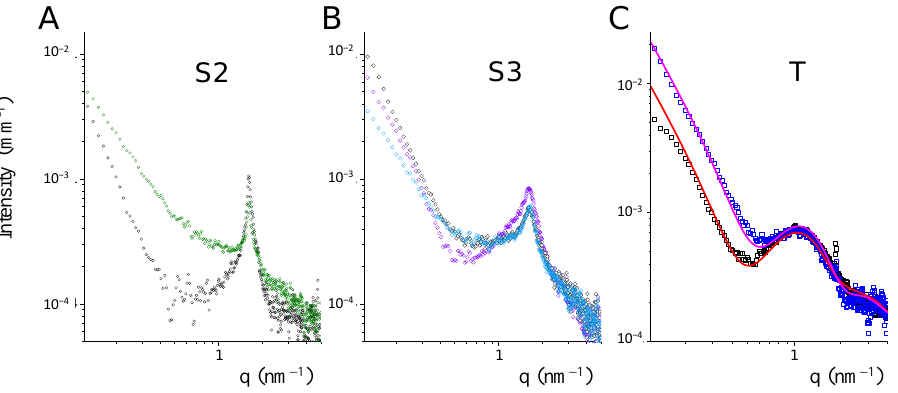
Figure 4. SAXS intensity spectra of Span-based and Tween-based niosomes. Panel ( A ) S2 sample without (black dots) and in presence of HA-Chol (1:1) molar ratio (green dots). Panel ( B ) S3 sample without (black diamonds) and in presence of HA-Chol (1:0.5) molar ratio (light blue diamonds) and (1:1) molar ratio (violet diamonds). Panel ( C ) T sample without (black squares) and in presence of HA-Chol (1:1) molar ratio (blue squares). Lines are the fits with a bilayer form factor. For both S2 and S3 Span-based niosomes, an intensity peak at q = 1.6 nm − 1